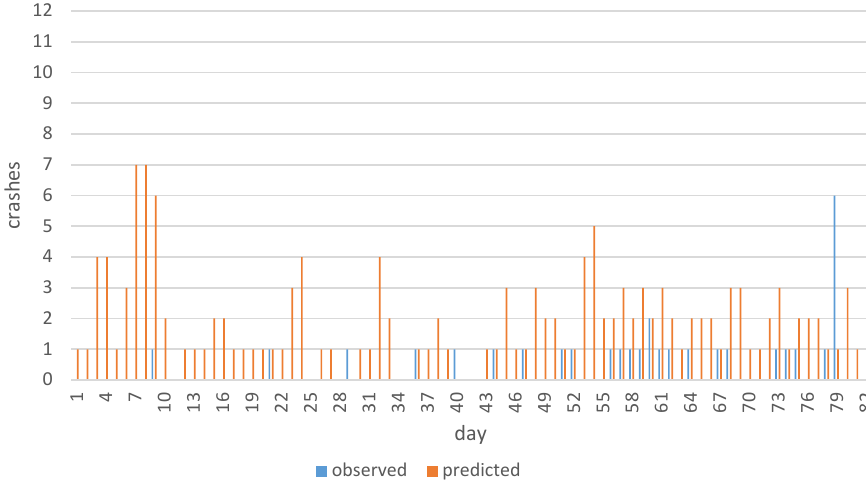
Figure 12. Prediction in Soochow direction of Figure 14. Prediction in Soochow direction of ANN.